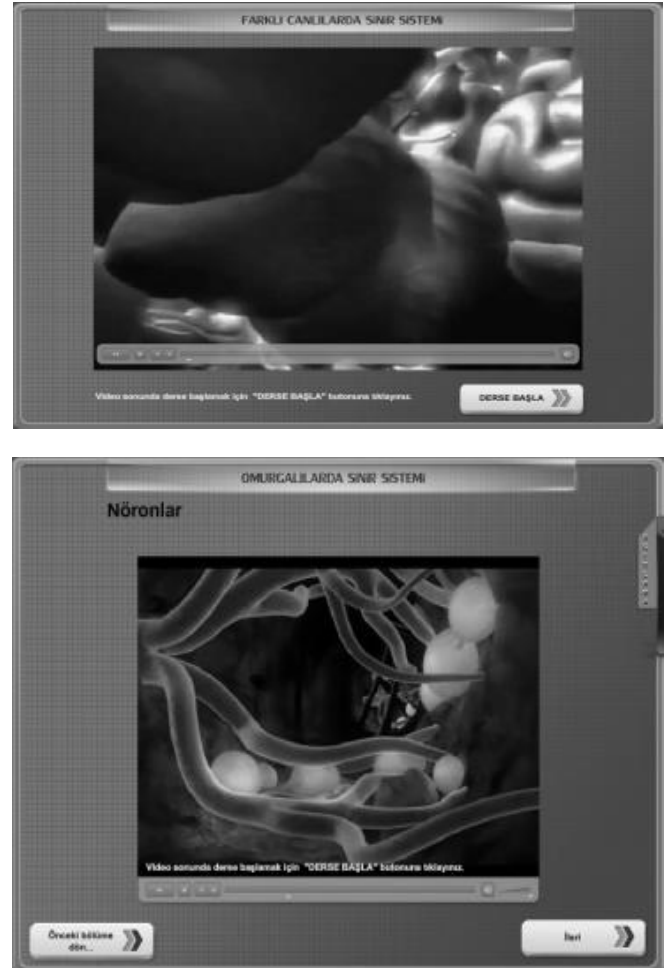
Figure 2 Screenshots of the video used as an Mbio